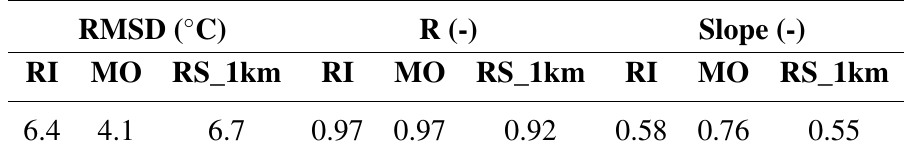
Table 3. Root mean square difference (RMSD), correlation coefficient (R) and slope of the linear regression between the soil Tends simulated by EBsoil for the RI and MO aerodynamic resistance retrieved from 1-m resolution data (RS_1km) and the soil Tends retrieved from 90-m resolution data, for the Yaqui and Urgell regions